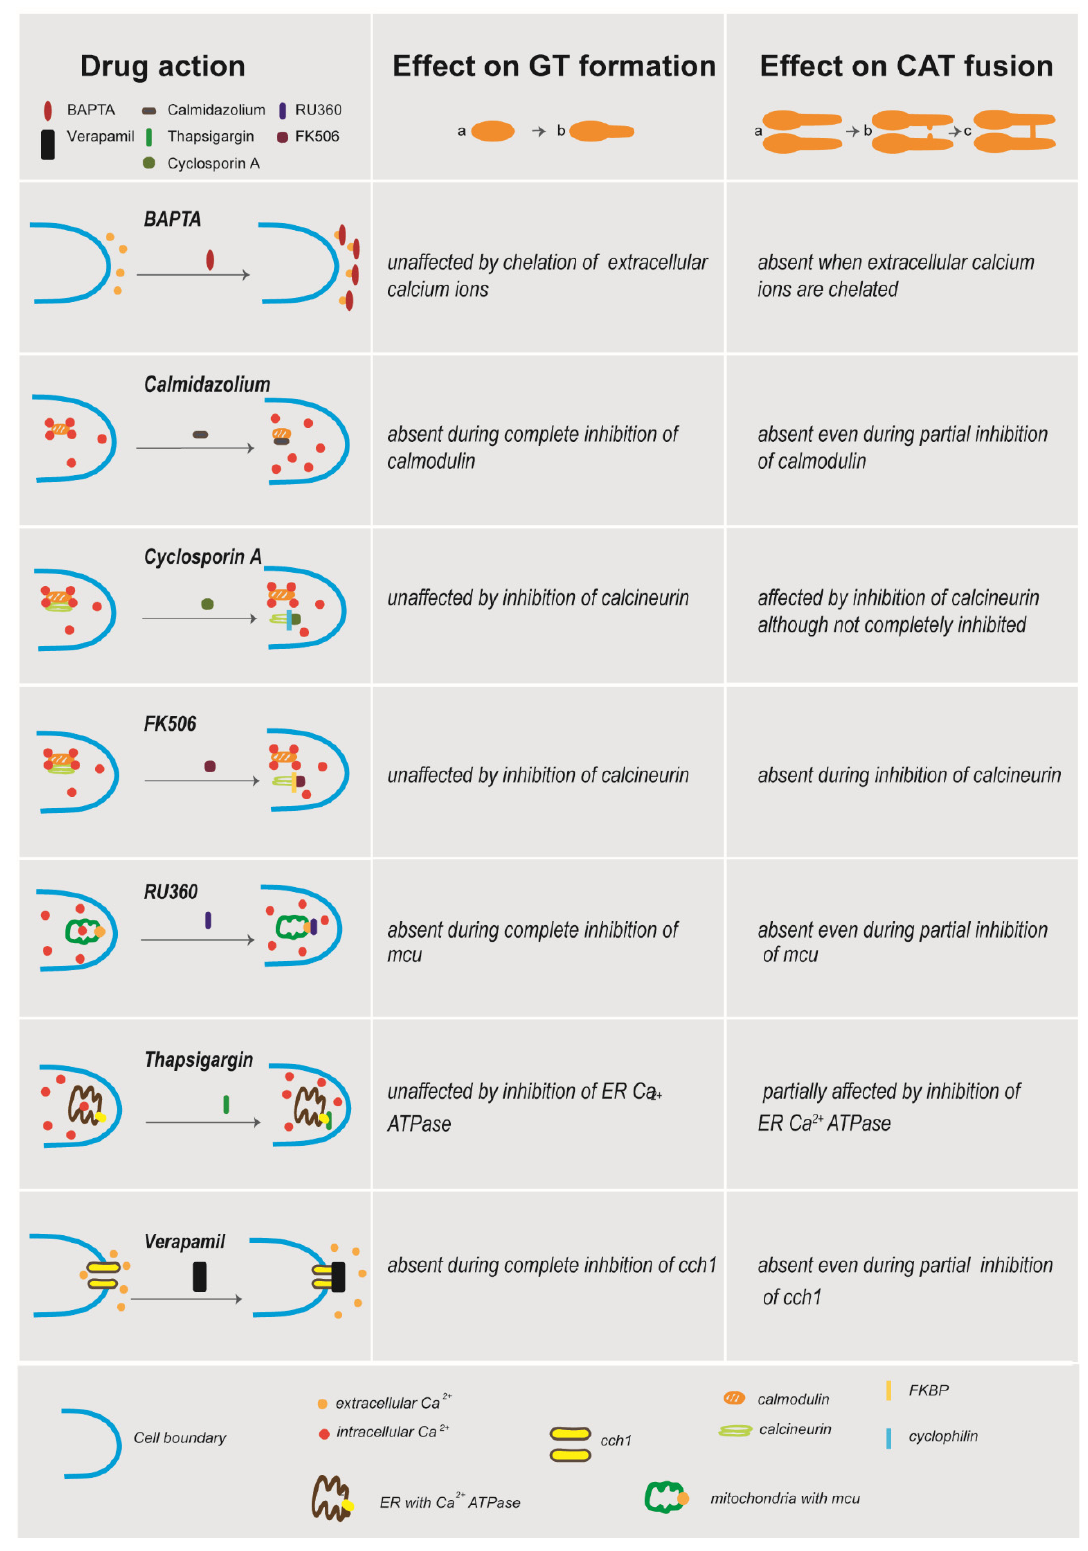
Figure 3. Schematic overview of the drug’s mode of action. The mode of action of each pharmaco- logical agent in the fungal cell are correlated with the effect of each treatment on germ-tube (GT) formation and CAT formation.